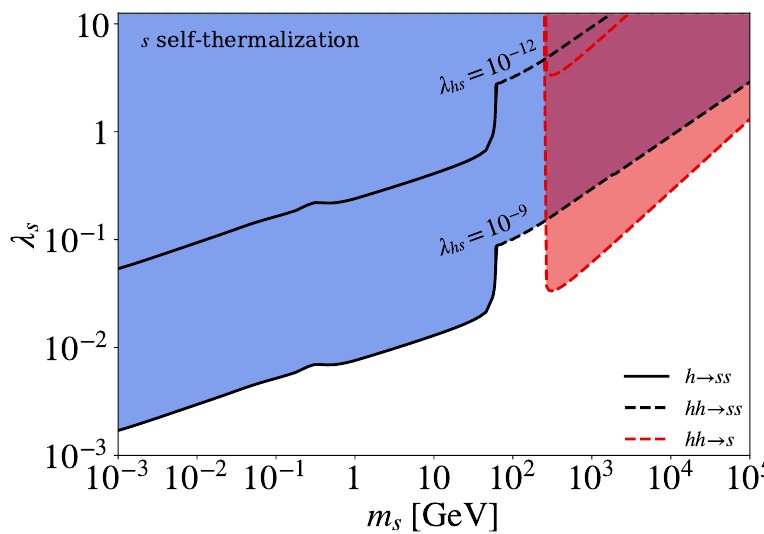
Figure 4 . Estimates of the upper bound on (cid:21) s from non-thermalization of s . In the shaded regions, the ss ! ssss process is e(cid:14)cient. The bound depends on n s and thus is sensitive to (cid:21) hs and the s -production mode. The displayed constraints correspond to two benchmark values of (cid:21) hs